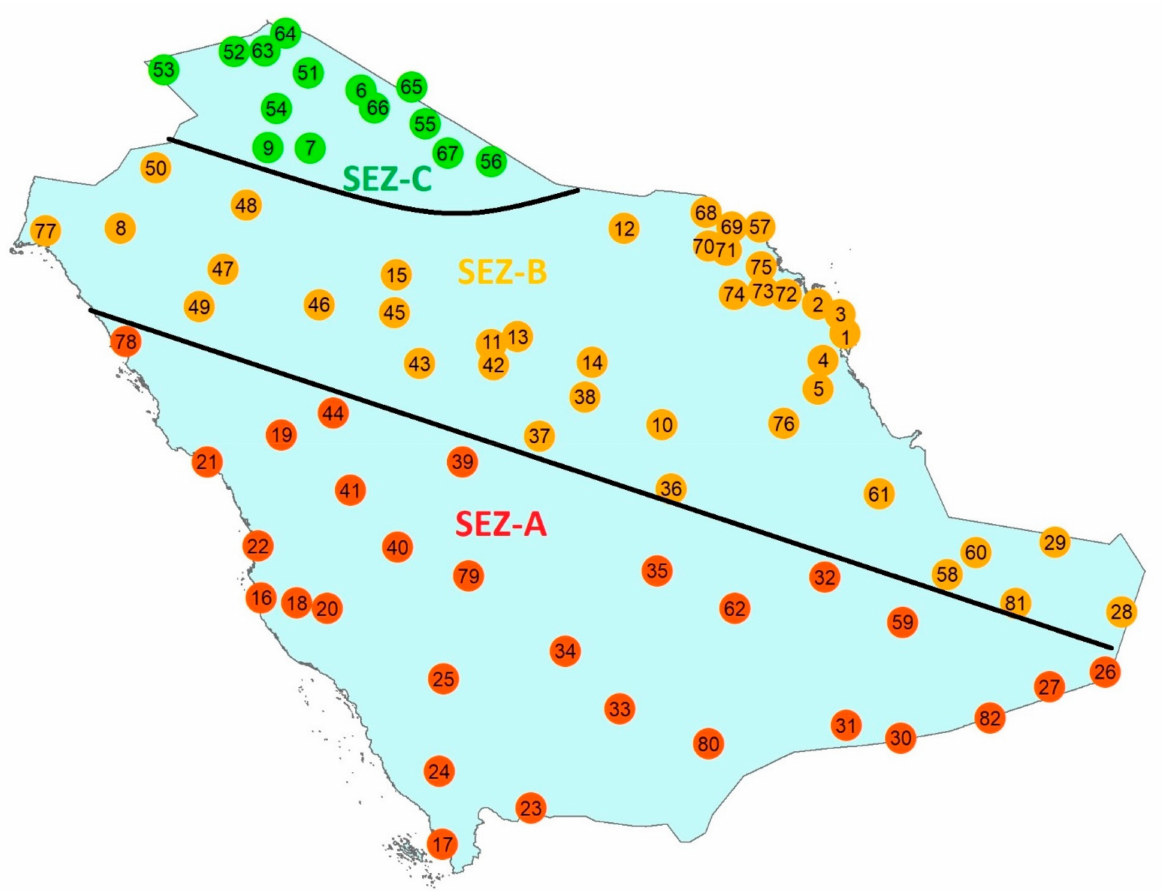
Figure 3. Corrected distribution of the 82 selected sites in Saudi Arabia for maximum H g,t,opt. β / ρ g . The numbers in the circles refer to those in column 1 of Table 1. The red circles correspond to sites with selected opt. β = 40 ◦ (SEZ-A), the orange with selected opt. β = 45 ◦ (SEZ-B), and the green ones with selected opt. β = 50 ◦ (SEZ-C). This figure is a reproduction of Figure 4 in